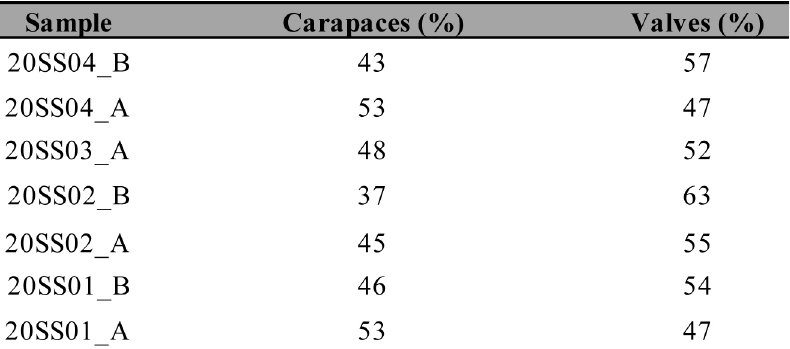
Table 2. Relative proportions of carapaces and valves per productive